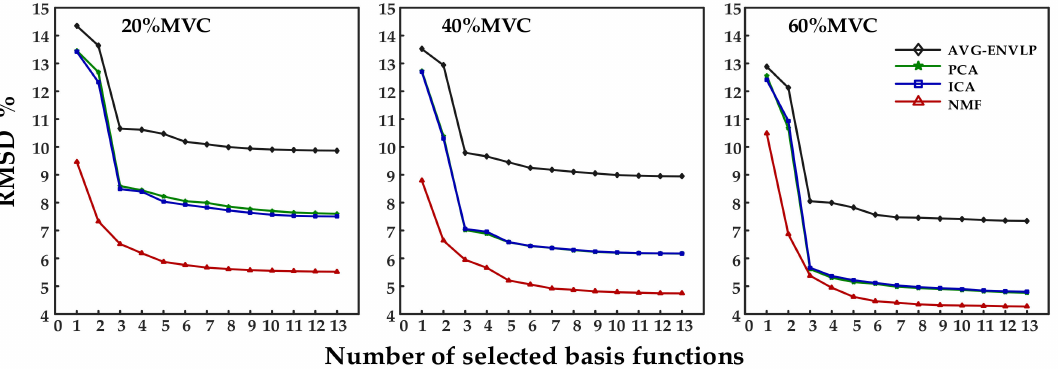
Figure 5. Effect of selected basis function number on RMSD for a representative subject (Subject